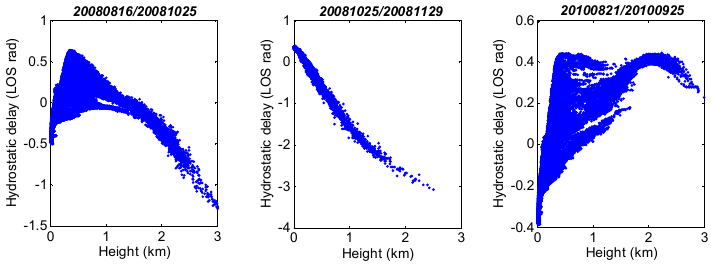
Figure 11. Relationship between height and hydrostatic delay estimated from ERA-I method in California.